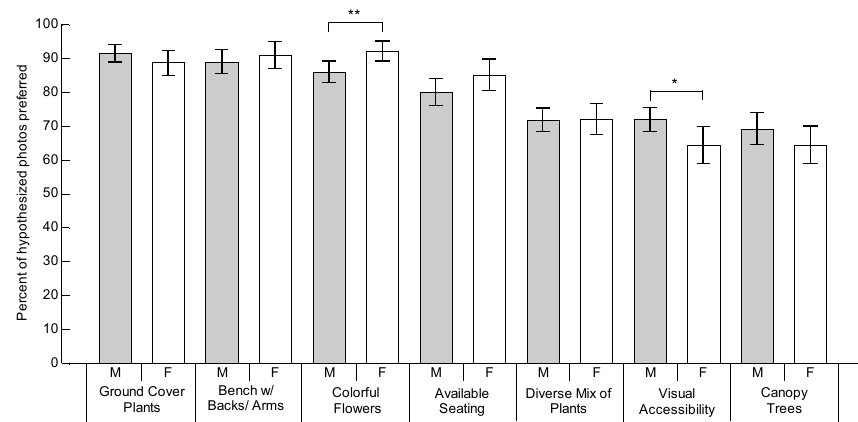
Figure 15. Mean with 95% confidence interval error bars for males and females.